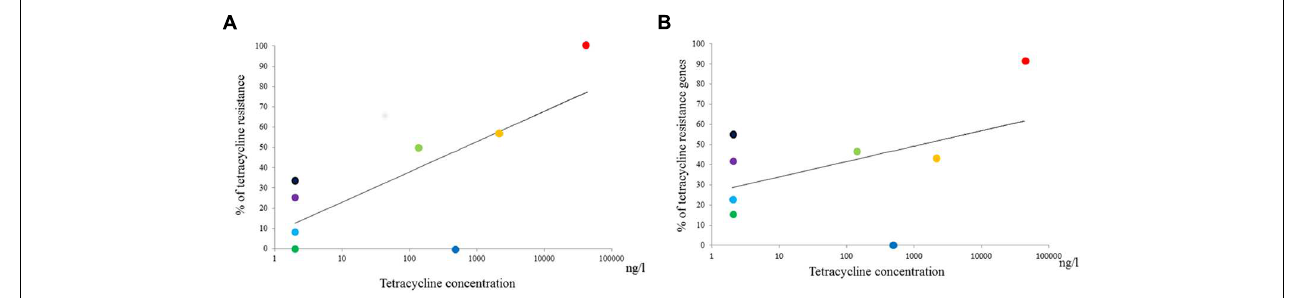
FIGURE 3 | Relationship between the tetracycline concentration at individual aquatic environments and (A) rates of tetracycline resistance or (B) the prevalence of tetracycline resistance genes among Aeromonas spp, respectively. Purple, Chao Phraya River; Black, The mouth of Chao Phraya River; Green, Ta Chin River; Sky Blue, City canal 2013; Yellow-Green, City canal 2014; Blue, Chicken farm; Red, Pig farm; Orange, Pig farm post-treatment.